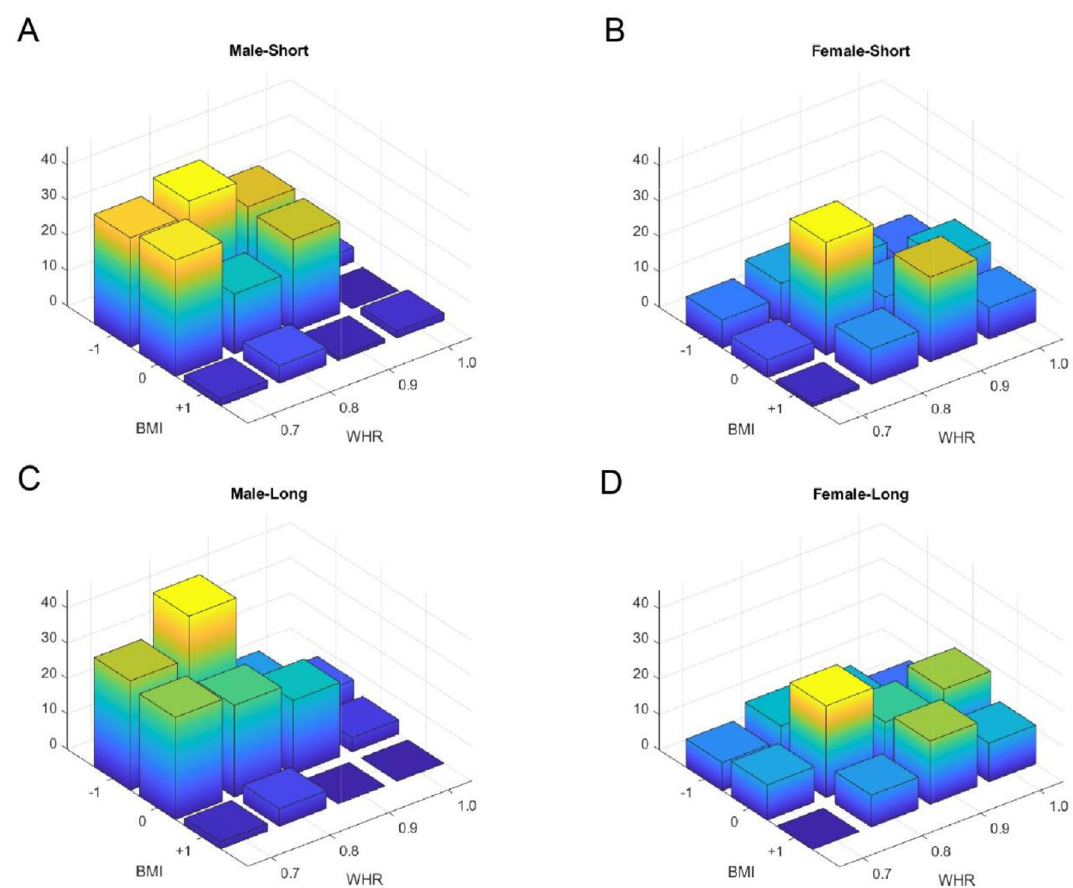
Figure 1. Histogram of the most attractive selected stimuli. X and y axes show BMI and WHR respectively, and the z-axis shows the number of participants that have selected the corresponding bin of the histogram. ( A ) Male-Short: male participant selecting for a short-term relationship; ( C ) Male-Long: male participant selecting for a long-term relationship; ( B ) Female-Short: female participant selecting for a short-term relationship; ( D ) Female-Long: female participant selecting for a long-term